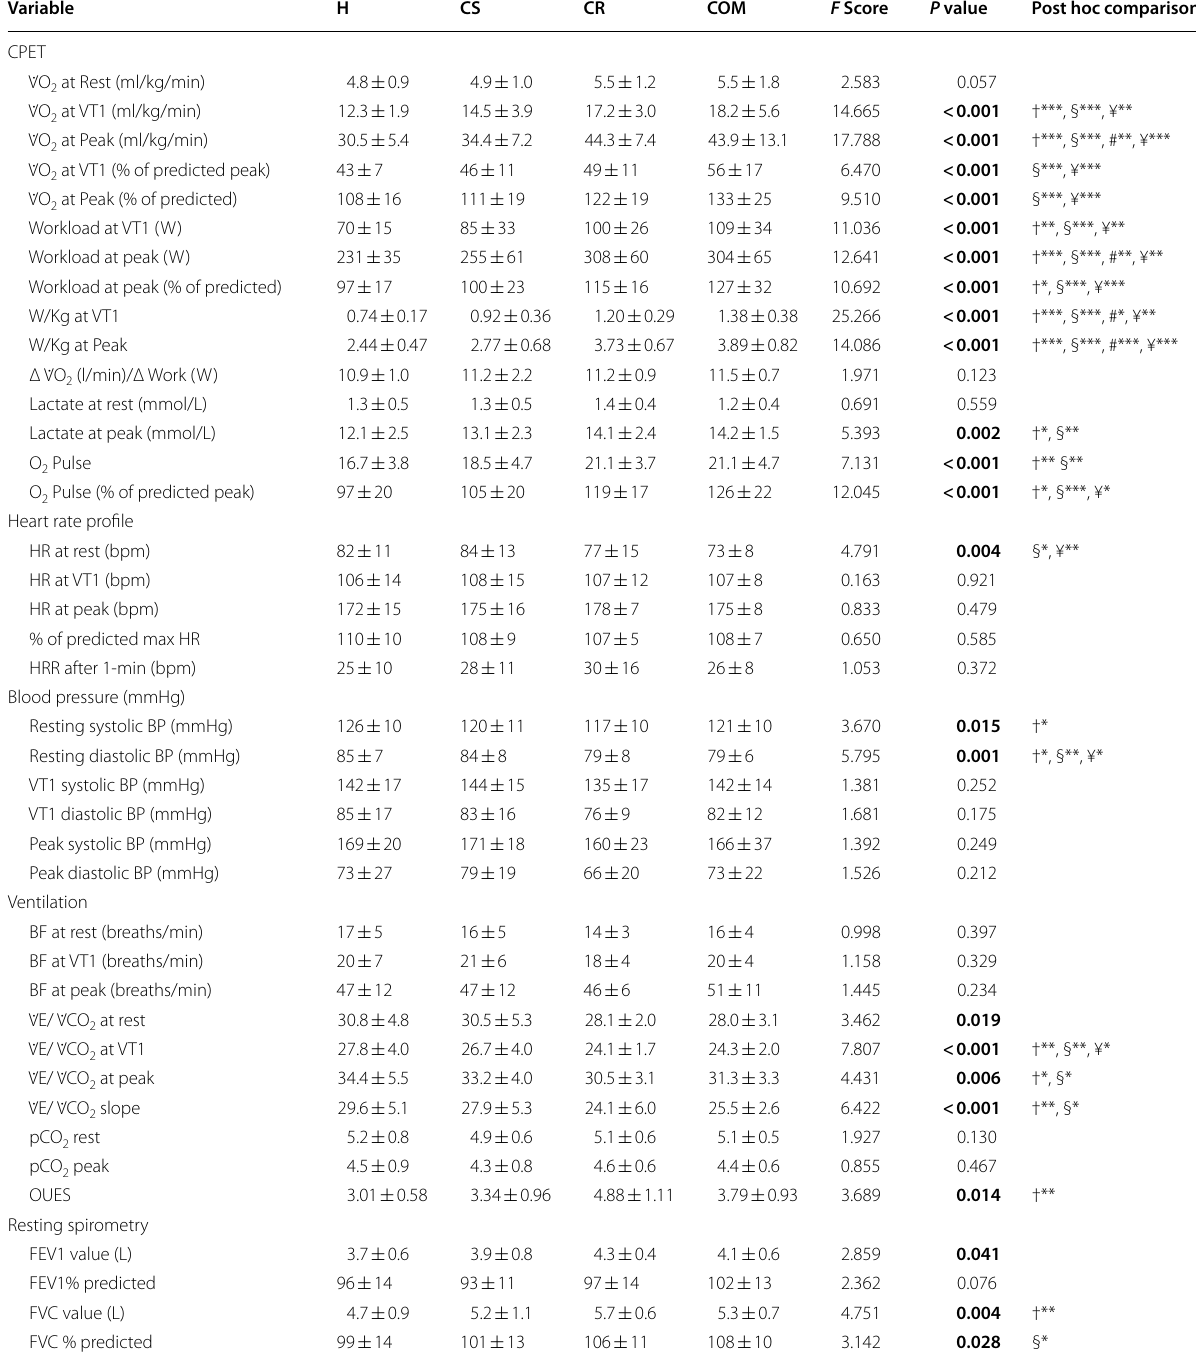
Table 4 Cardiopulmonary exercise testing (CPET) parameters (mean